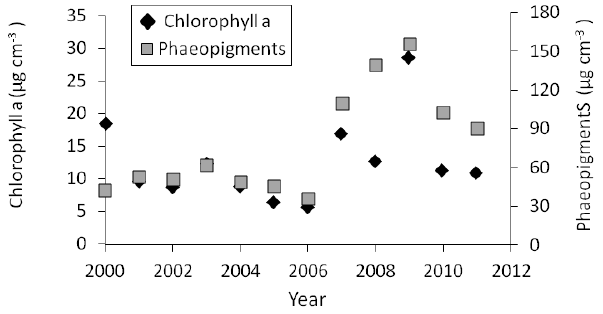
Fig. 6. Taxa observed at HG I but not included in statistical analysis.